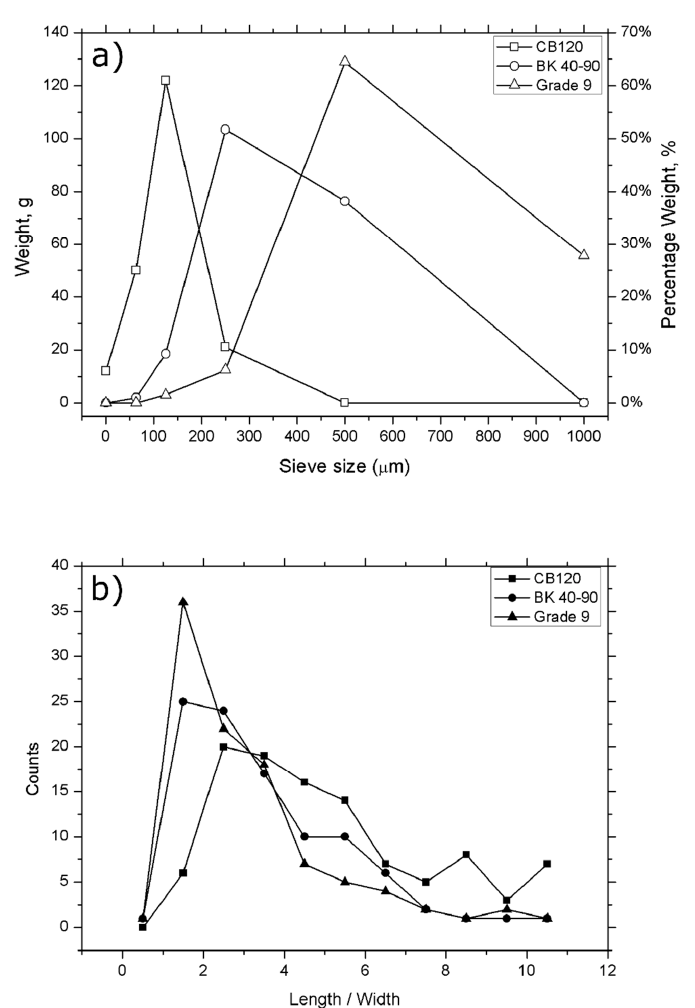
Figure 2. ( a ) Histogram of the weight distribution for di ff erent wood flour particles, and ( b ) histogram of the relationship between the length / width of di ff erent wood flour particles.